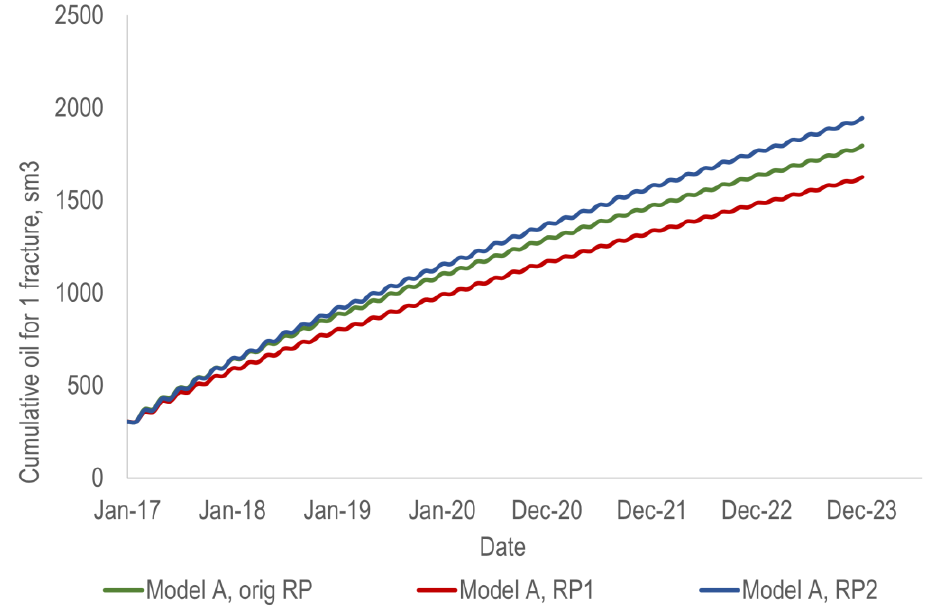
Figure 5. Effect of relative permeability curves on cumulative oil production, simulation results.